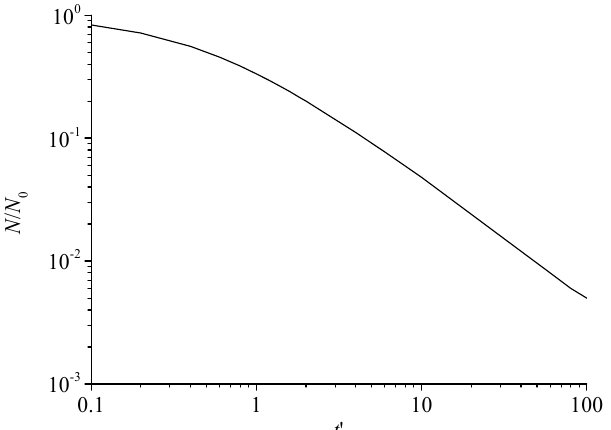
Figure 7. The total number of dimensionless sulfur particles varies with dimensionless time.